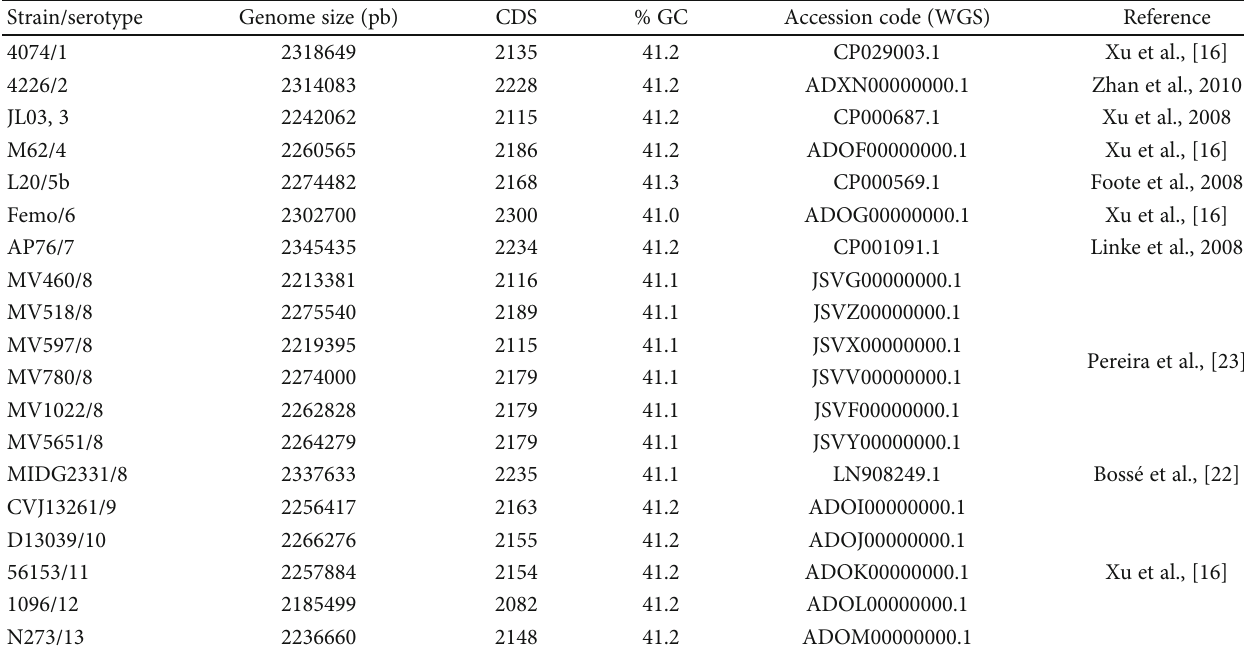
Table 1: A. pleuropneumoniae genomes used in this study.